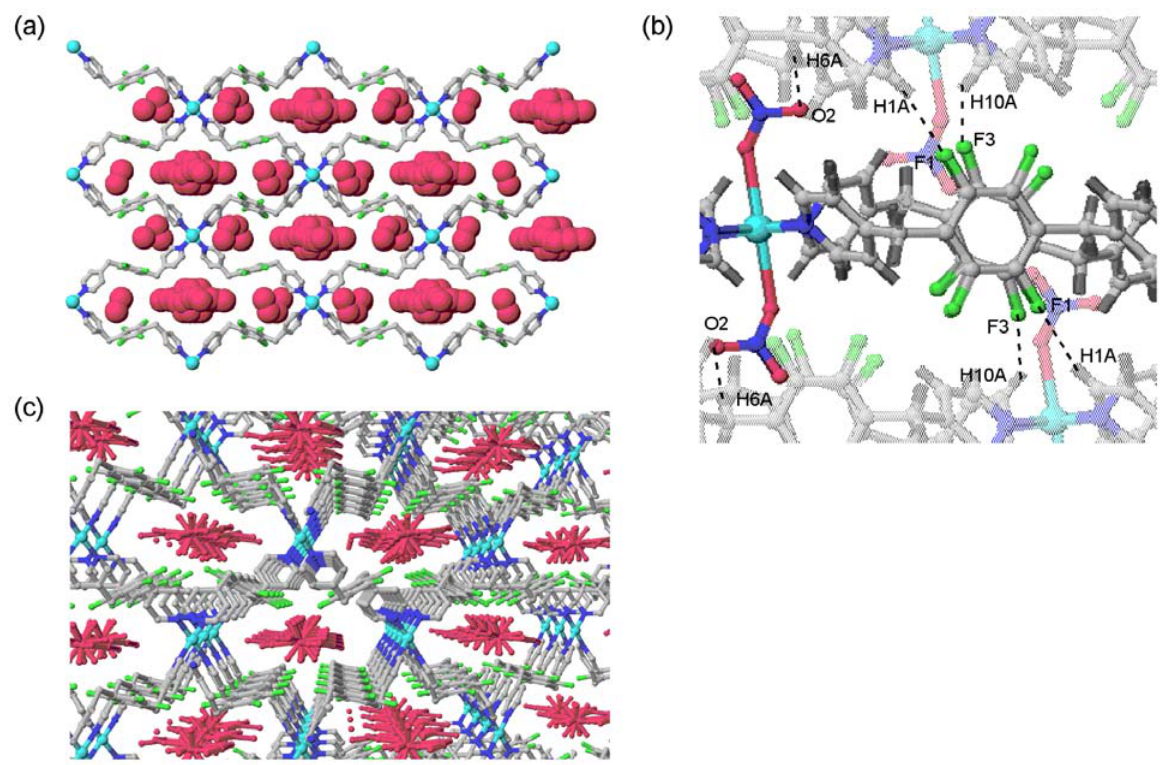
Figure 2. Crystal structure of 3 . (a) Top view of the 2D sheet structure. Hydrogen atoms, solvent EtOH molecules and nitrate anions are omitted for clarity. (b) side view of the stacking layers linked by hydrogen bonds. (c) Top view of the stacking